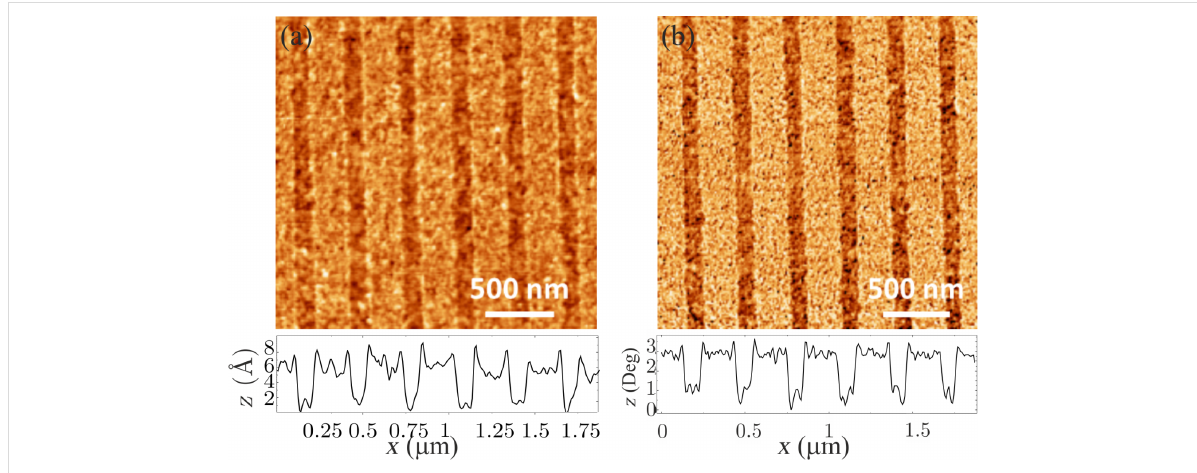
Figure 4: AFM topography (a) and phase (b) images of a chemical guiding pattern created by EBL followed by oxygen plasma modification on the brush sample cooled in nitrogen (see Figure 1). Representative cross sections are shown below both images.